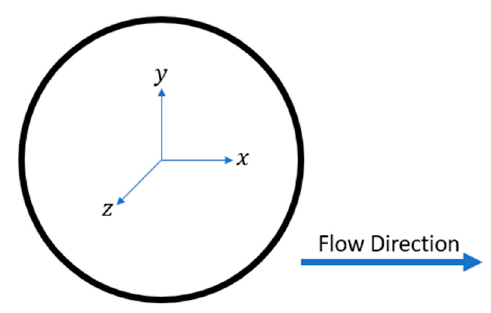
Figure 7. Polar coordinate system.